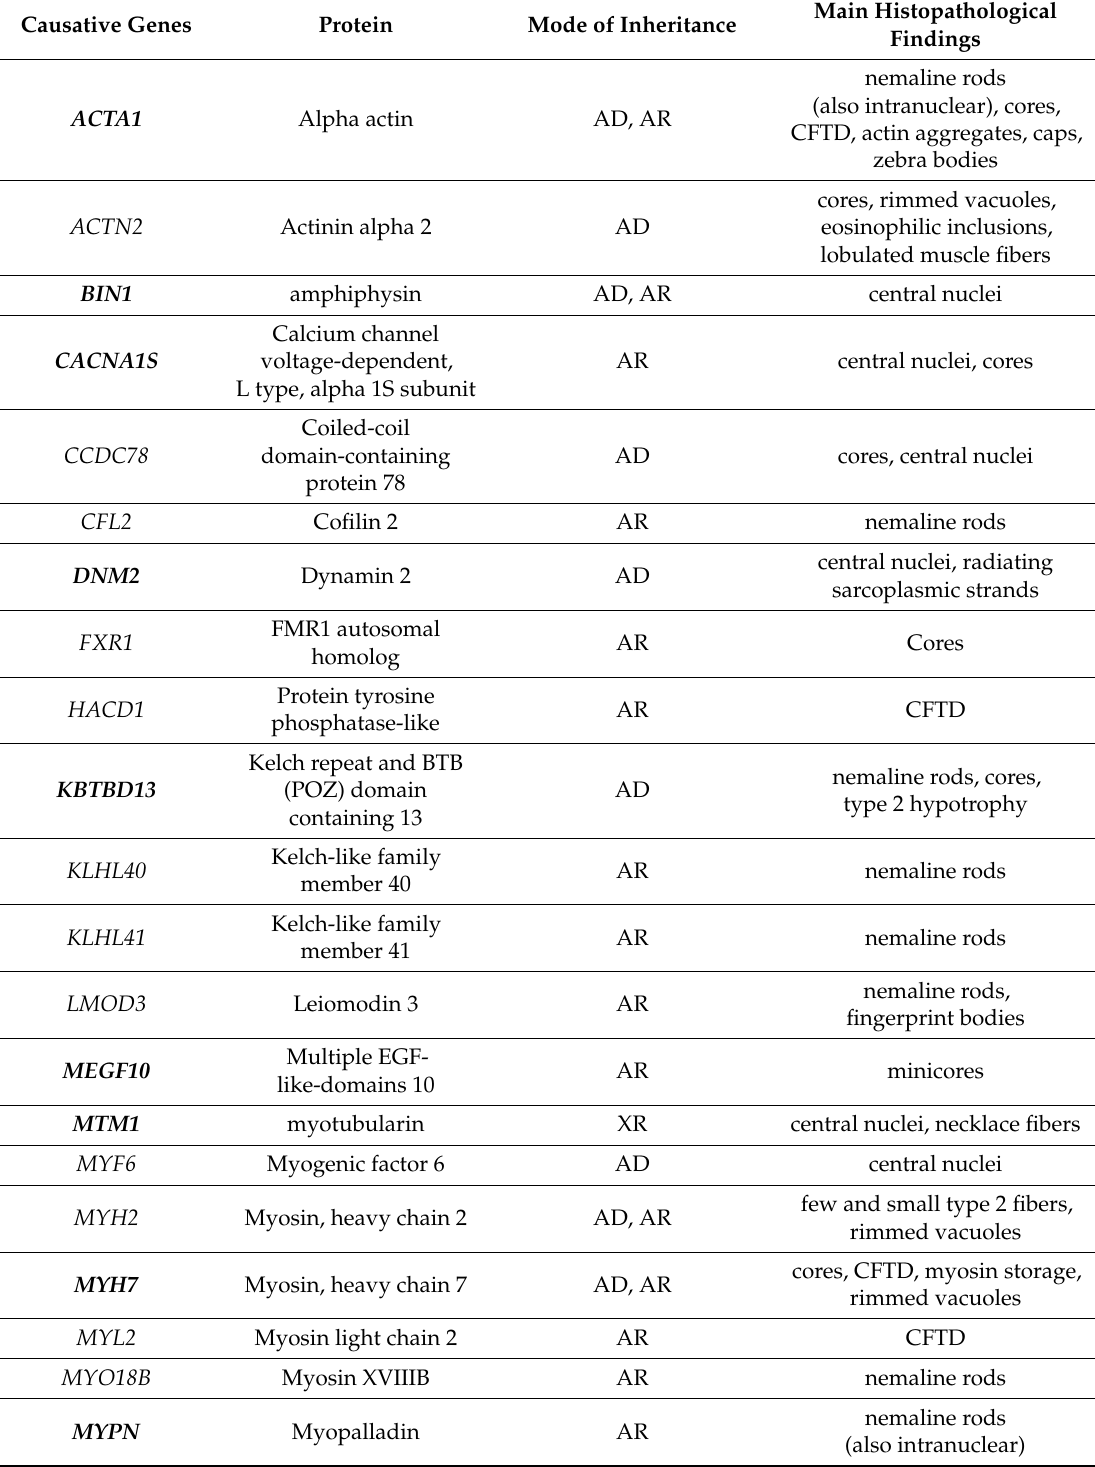
Table 1. Summary of the genes and proteins implicated in congenital myopathies (CMs) and their main histopathological associations (highlighted in bold are those genes that have been also associated with adult onset